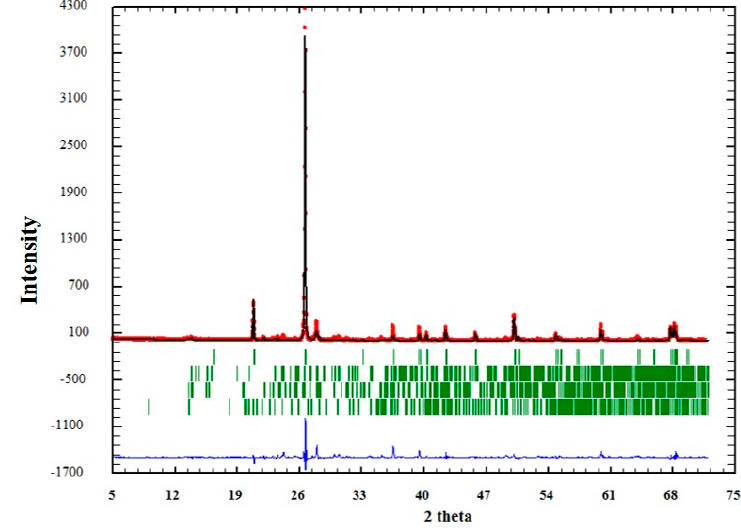
Figure 4. Adjustment through the Rietveld refinement of sample QM1.